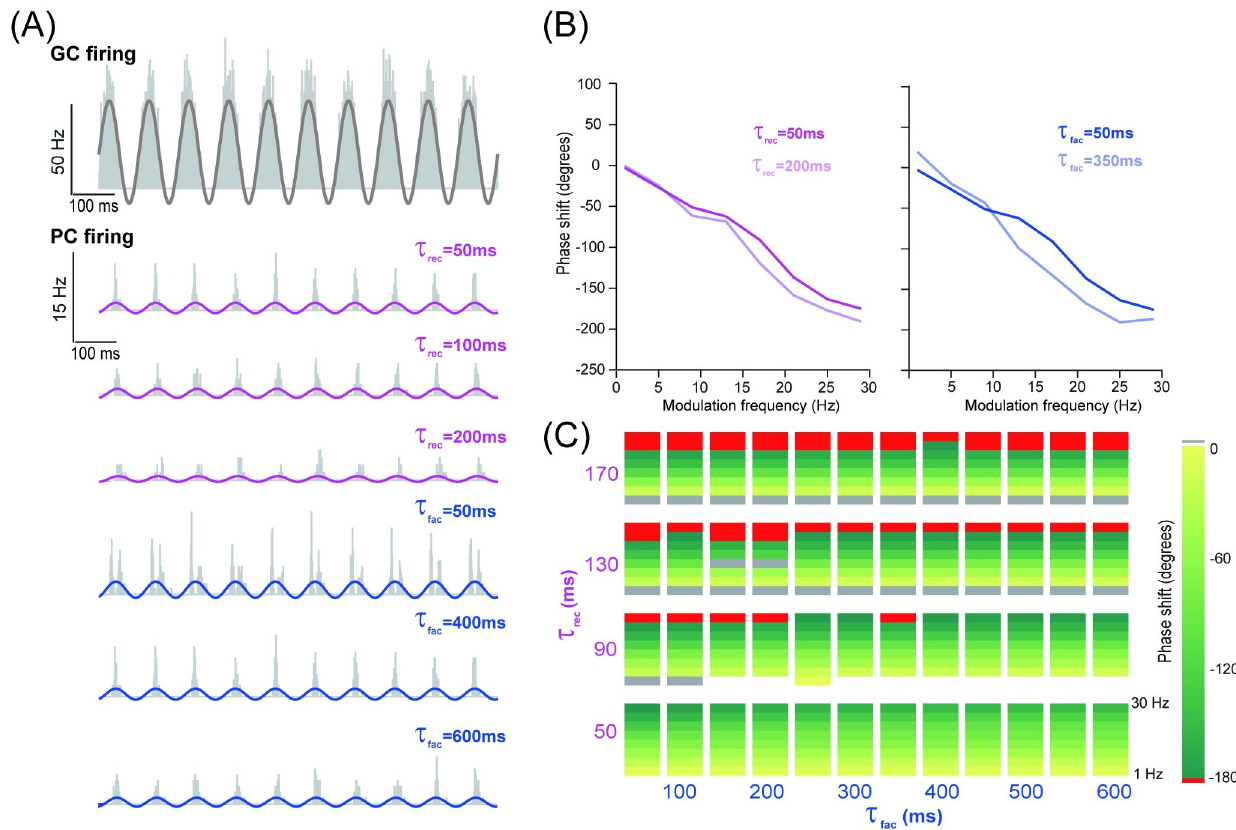
Fig 5. PC phase modulated by timescales of short-term dynamics of GC-PC synapses. (A) Histograms of spikes in GCs (top) and PCs (bottom) in response to an input spike train sinusoidally-modulated at 10 Hz, with three examples of time constants of recovery τ τ fac (fixed τ rec = 50 ms). (B) Phase shift as a function of input frequency for (left) τ rec and (right) τ fac , with similar settings as in (A). (C) Phase shift in the parameter space of τ and τ . Each inner rectangle represents a PC phase shift spectrum changing over different modulation frequencies (0-30 Hz). rec fac